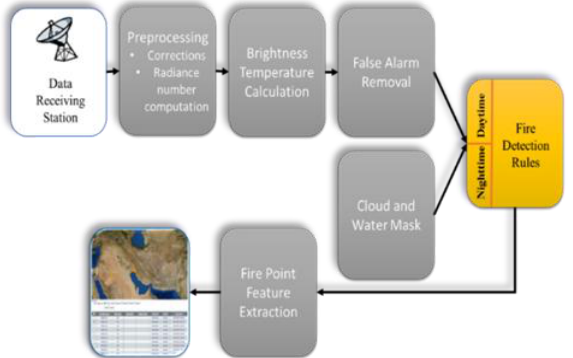
Figure 2. Centralized service chaining